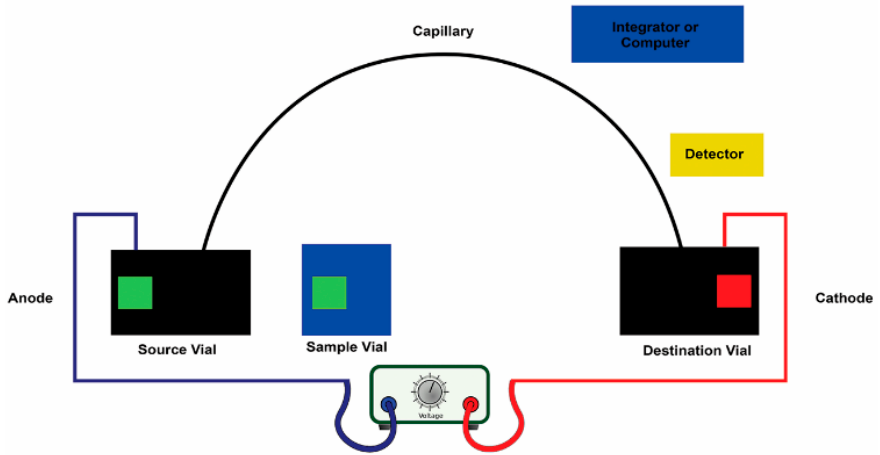
Figure 9. Protein mixtures can be characterized in terms of their separations by capillary electro- phoresis (CE). The detection of peptide in CE is usually based on the ultraviolet (UV) absorbance of the peptide bond at or near 200 nm.